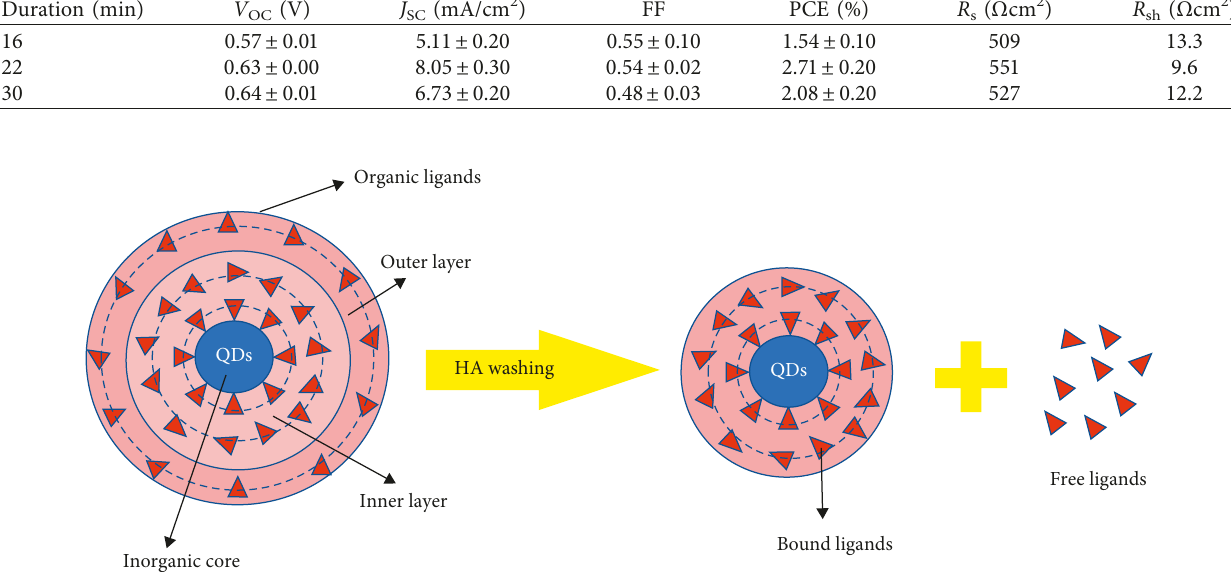
Figure 4: Schematic illustration of the ligands bound to the CdSe QDs and free ligands after HA